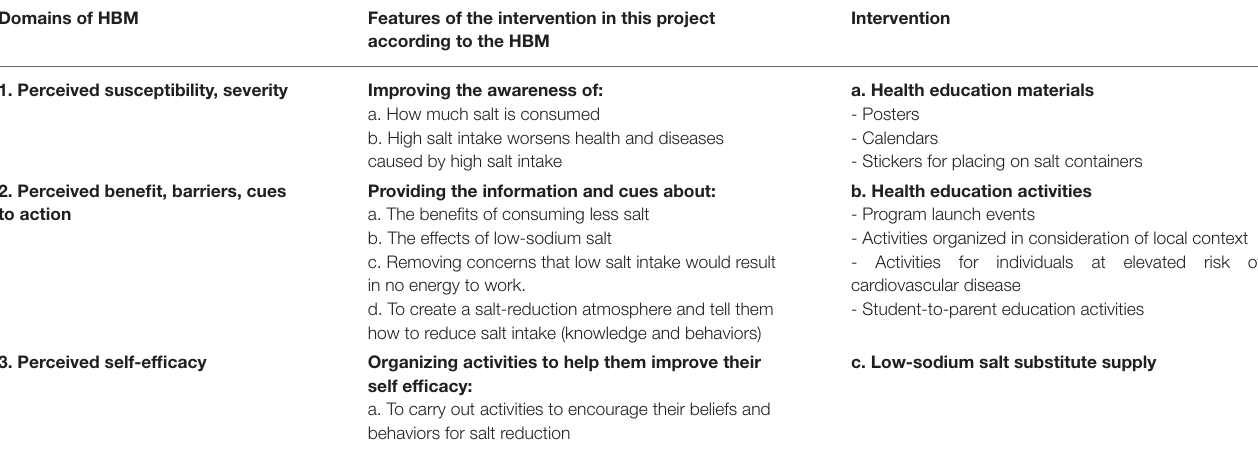
TABLE 1 | The health belief model and derived intervention used in this project. Domains of